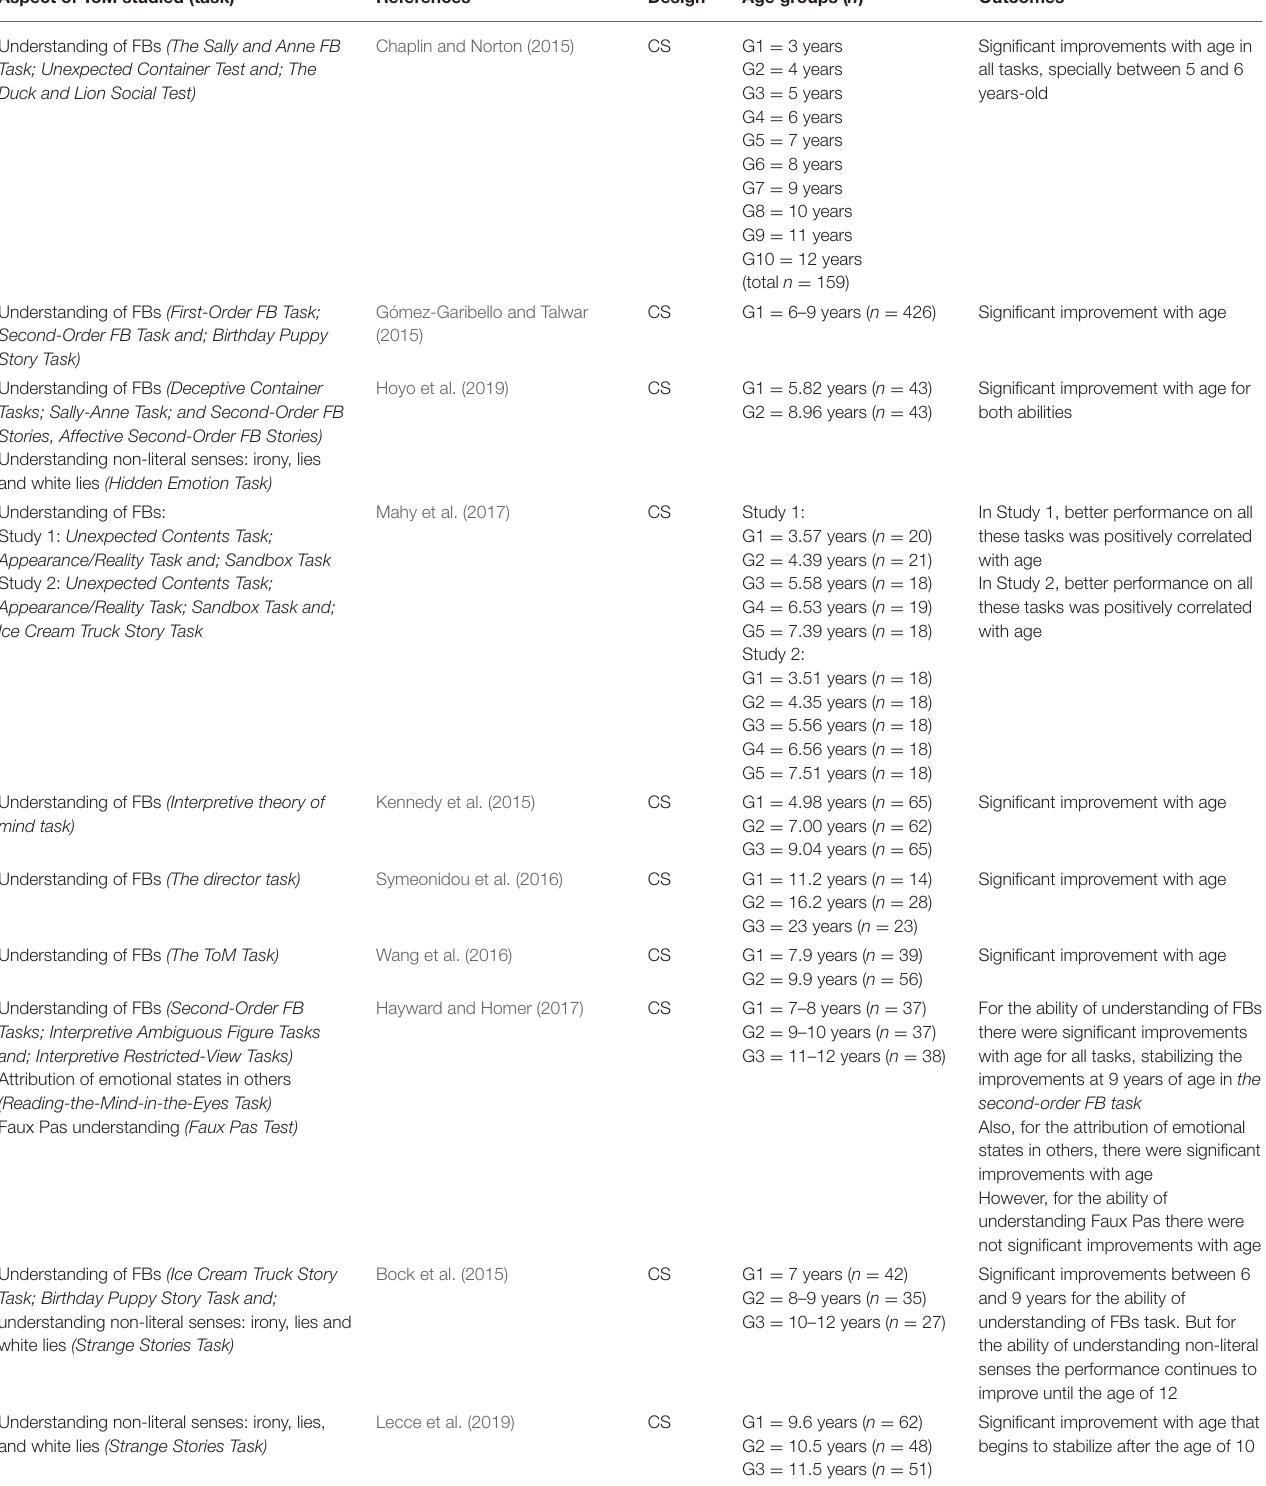
TABLE 6 | Studies on the development of the ToM ( n =